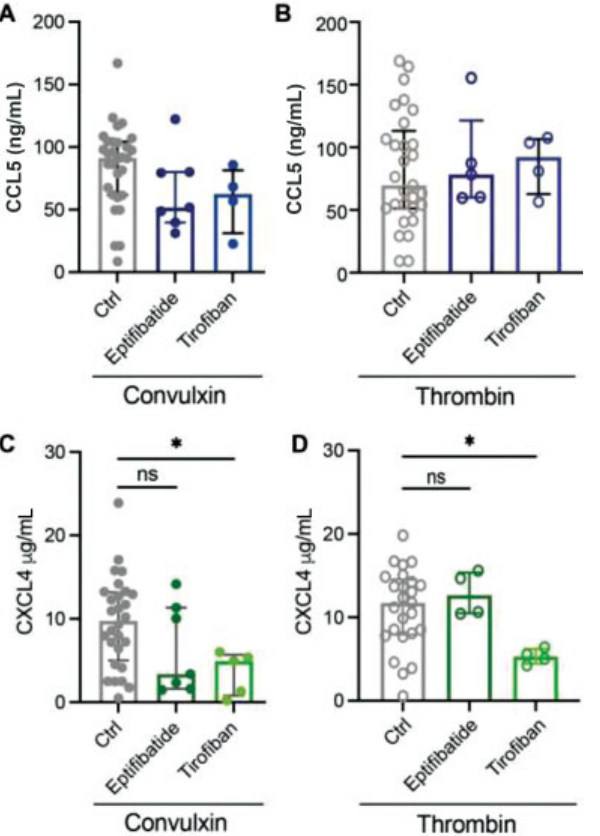
Fig. 2 Effects of antiplatelet drugs against α IIb β 3 on chemokine release. Washed platelets (2 (cid:1) 10 8 /mL) were incubated with indicated compounds, 5minutes prior to platelet activation, and chemokine release was determined: CCL5 release after convulxin ( A ) and thrombin ( B ) activation and CXCL4 release after convulxin ( C ) and thrombin ( D ) activation. Closed circles represent convulxin activation and open circles represent thrombin activation. CTRL: n ¼ 25 – 30; epti fi batide: n ¼ 4 – 7; and tiro fi ban: n ¼ 4 – 5. Median with interquartile range. (cid:4) p < 0.05, Kruskal – Wallis with Dunn ’ s test.